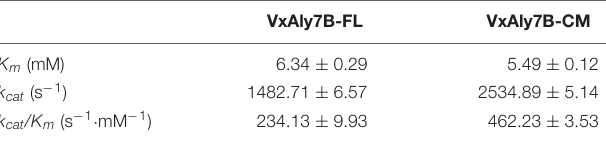
TABLE 2 | Enzyme kinetic parameters of recombinant VxAly7B-FL and VxAly7B-CM.